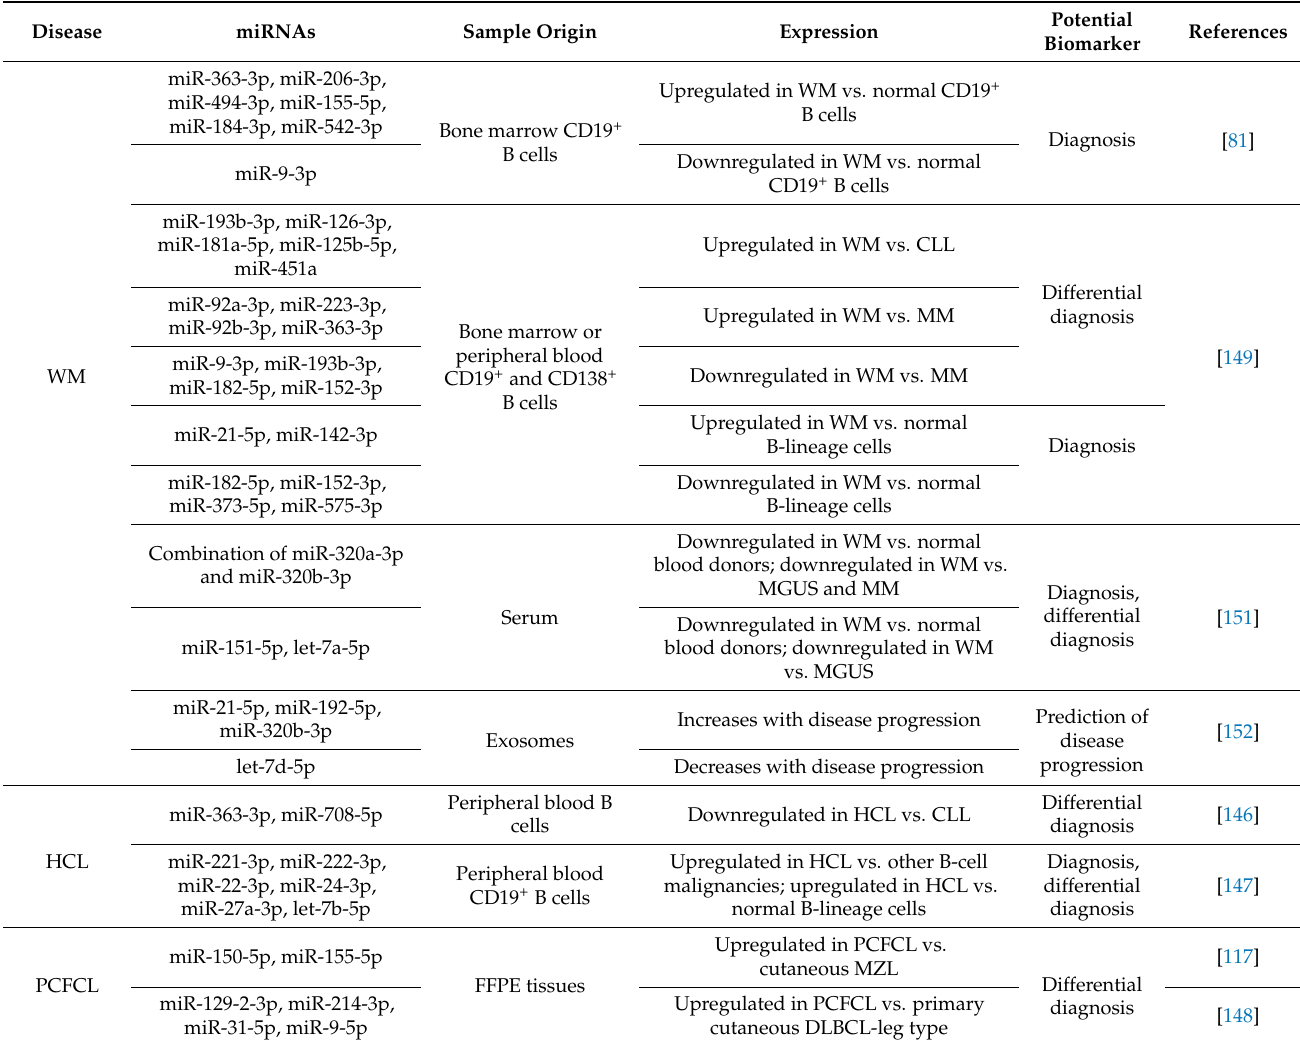
Table 4. miRNAs as candidate biomarkers in rare indolent B-cell